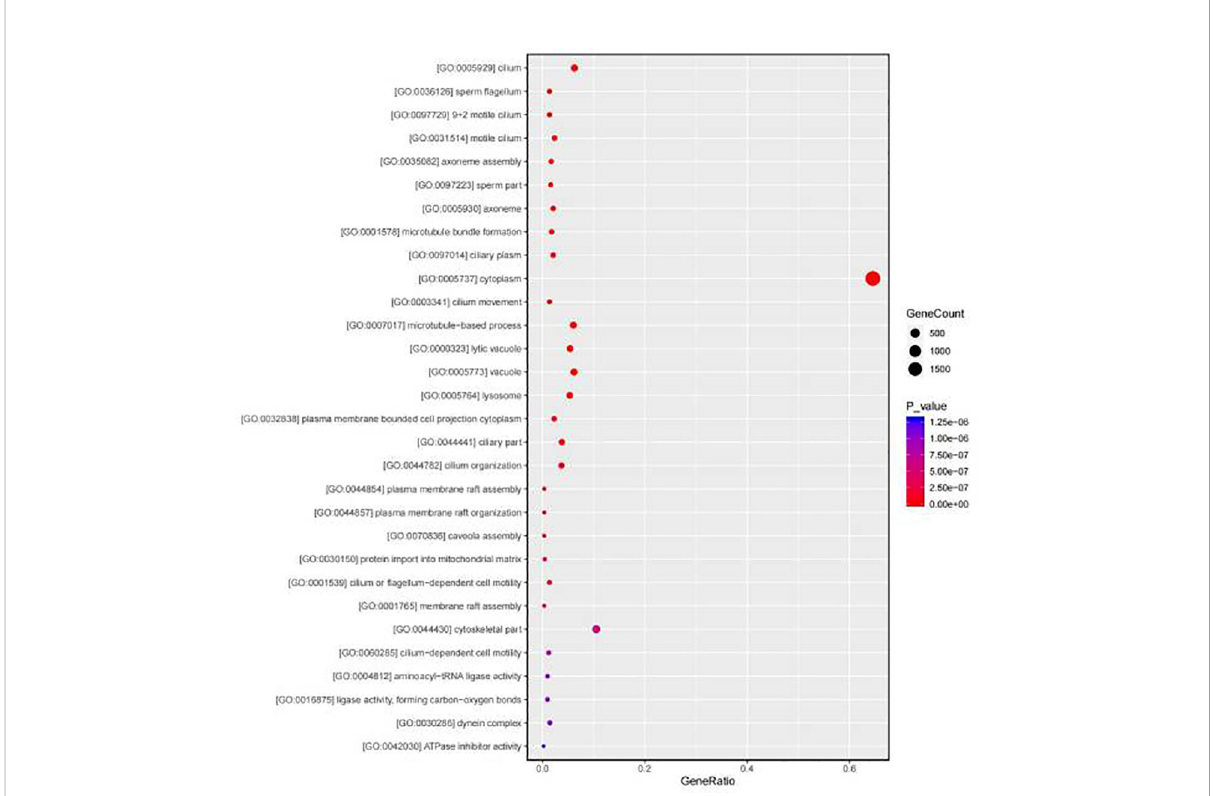
FIGURE 3 GO classi fi cations of DEGs. The most abundant pathways are cilium and